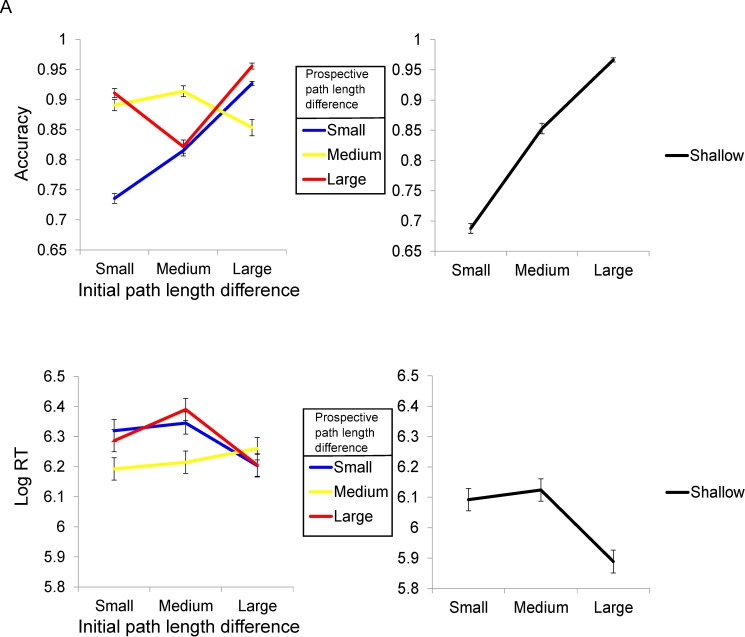
Behavioural Results.(A) Accuracy during choice phase. Left: Significant interaction (p < 0.001) for initial versus prospective path length differences in deep mazes. Deep mazes are split by small–small, small–medium, small–large, medium–small, medium–medium, medium–large, large–small, large–medium, and large–large path length differences at the initial choice point (i.e., the shortest options for either choice at the starting location) and the two available paths at the prospective choice point, respectively. Right: Significant positive linear trend in accuracy (p < 0.001) with increasing path length differences for shallow mazes. Shallow mazes are split by small, medium, and large path length differences. (B) Log RT during the choice phase. Left: Significant interaction (p < 0.001) for initial versus prospective path length differences in deep mazes. Deep mazes are split by small–small, small–medium, small–large, medium–small, medium–medium, medium–large, large–small, large–medium, and large–large path length differences at the initial choice point (i.e., the shortest options for either choice at the starting location) and the two available paths at the prospective choice point, respectively. Right: Significant negative trend (p < 0.001) in log RT with increasing path length differences in shallow mazes. Shallow mazes are split by small, medium, and large path length differences. See S1 Data for participant data.